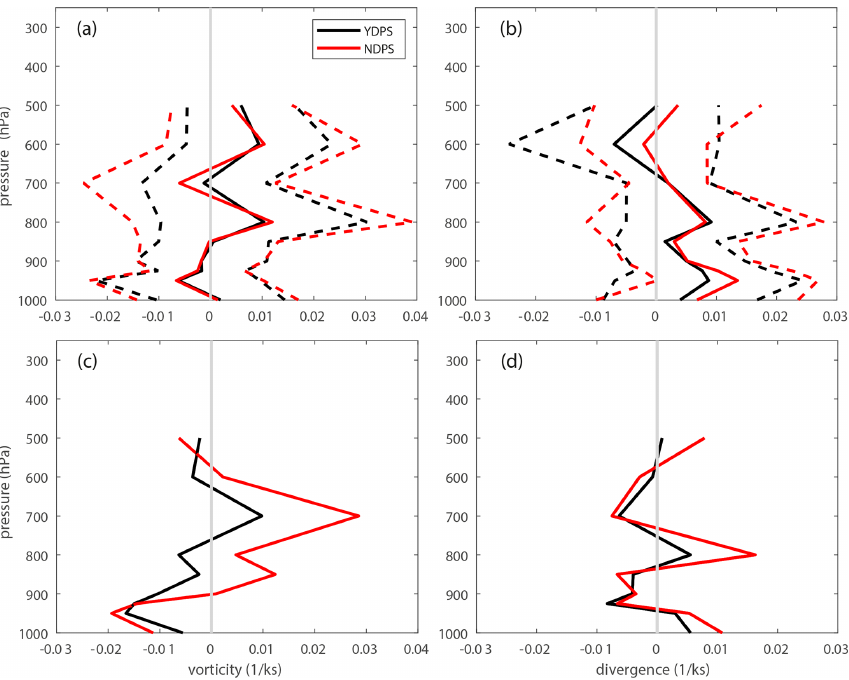
Figure 7. Similar to Fig. 5 but for (a) vorticity departures for all cases, (b) divergence departures for all cases, (c) vorticity departures for the special case in box B3, and (d) divergence departures for the special case in box B3.